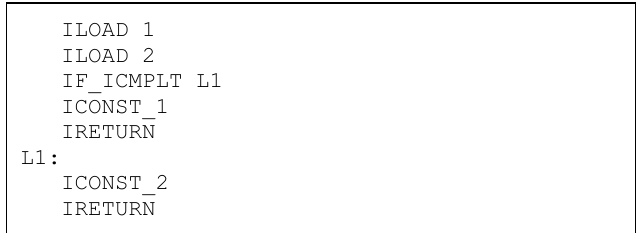
Fig. 5. First branching example.